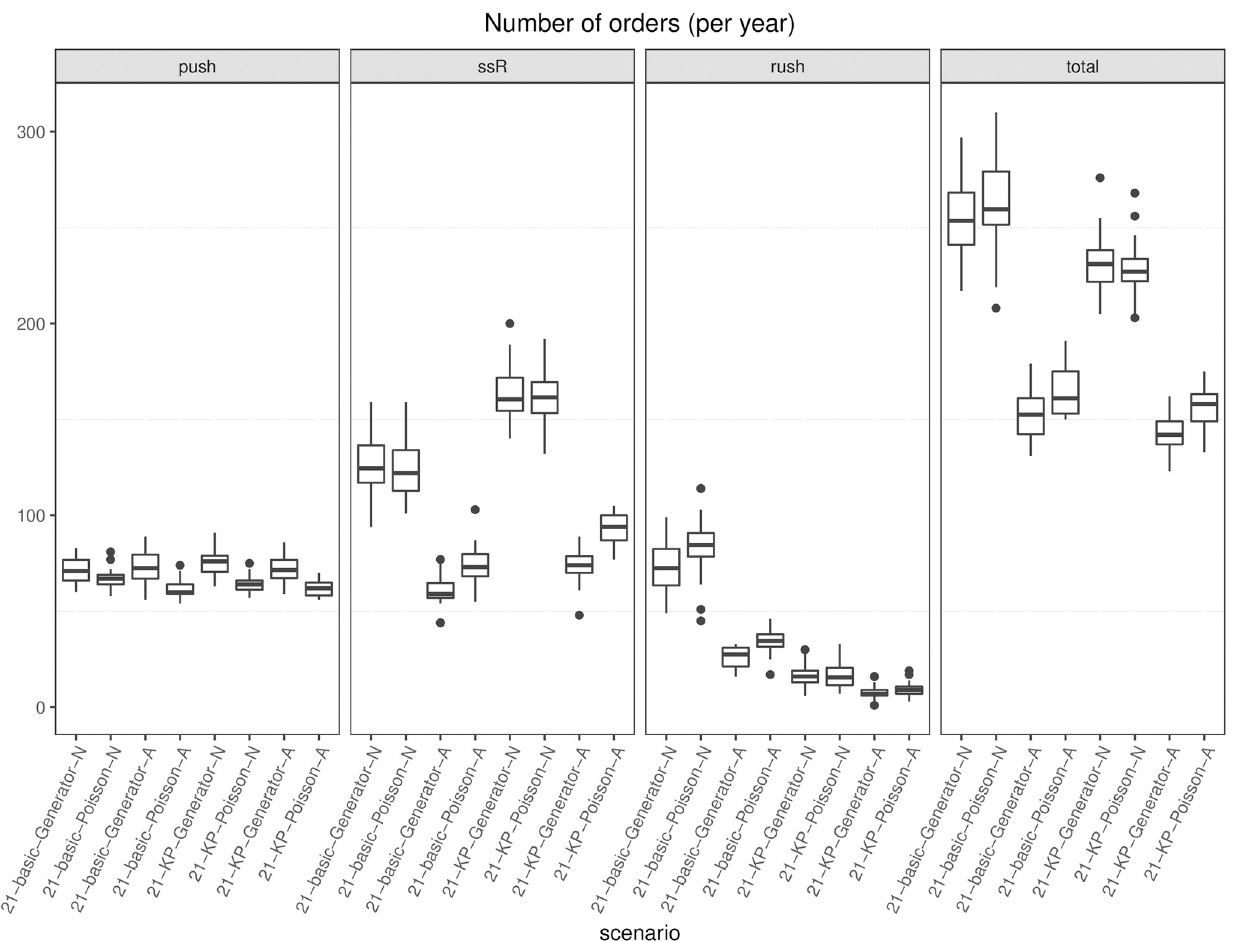
Fig 10. Boxplots of the orders (push, replenishment, all). On the left are the boxplots of the number of days with push orders per year. In the middle are the replenishment and rush orders. On the right part, all orders are considered, push and pull. Each boxplot refers to 30